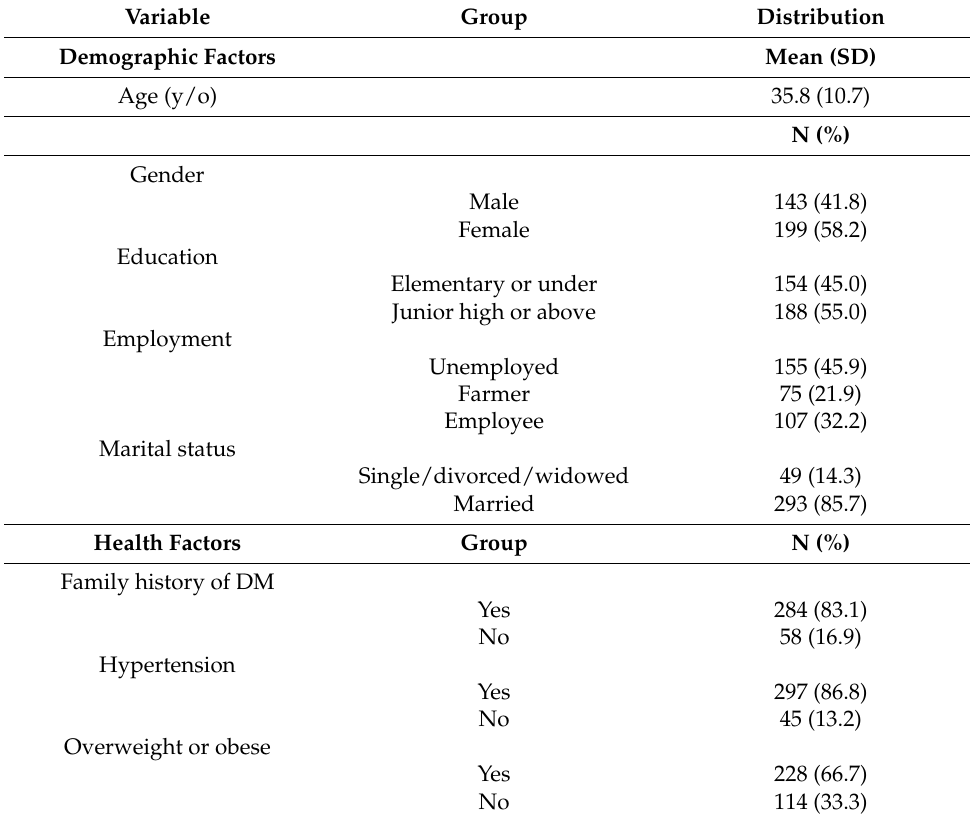
Table 1. Distribution of demographic characteristics and health factors ( n =